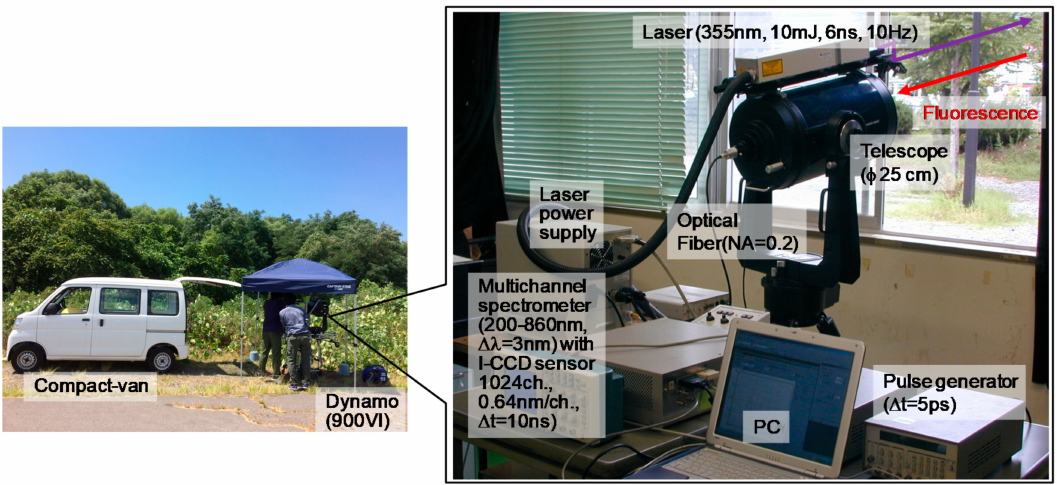
Figure 3. Photographs of the laser-induced fluorescence spectrum (LIFS) lidar ( right ) and the field experiment ( left